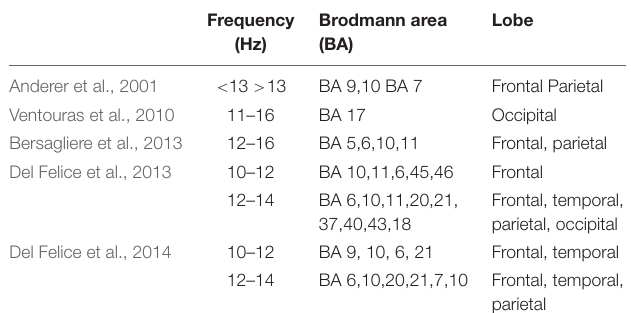
TABLE 1 | Source localization studies of sleep